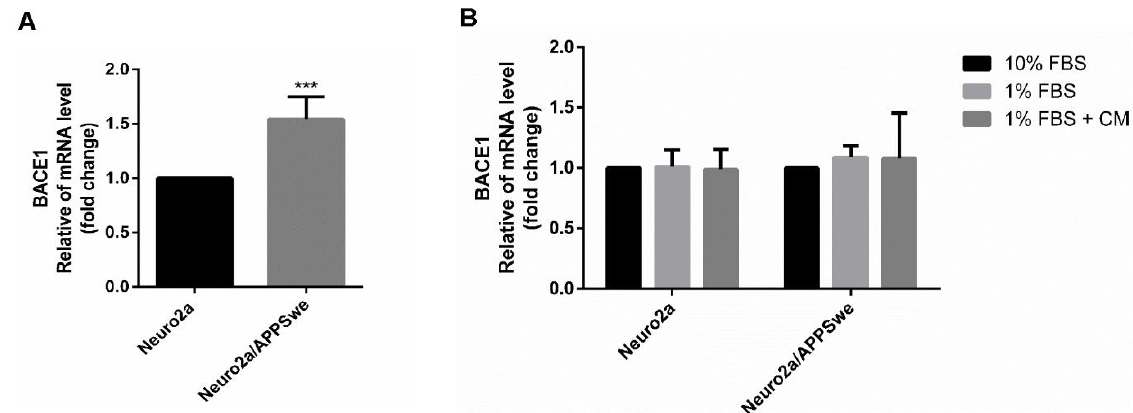
Figure 9. BACE1 mRNA expression level. ( A ) Neuro2a/APPSwe cells showed significantly higher level of BACE1 gene expression than Neuro2a cells after 48 h of treatment in 1% FBS medium. ( B ) BACE1 mRNA level between treatment groups of Neuro2a and Neuro2a/APPSwe cells was normalized vs. 10% FBS group for each cell type. BACE1 gene expression level in both Neuro2a and Neuro2a/APPSwe cells was not altered when treatment with 10 µg/mL of CM extract for 48 h compared to 1% FBS treatment in each cell. Values are mean ± SD of at least three independent experiments. *** p-value < 0.001.